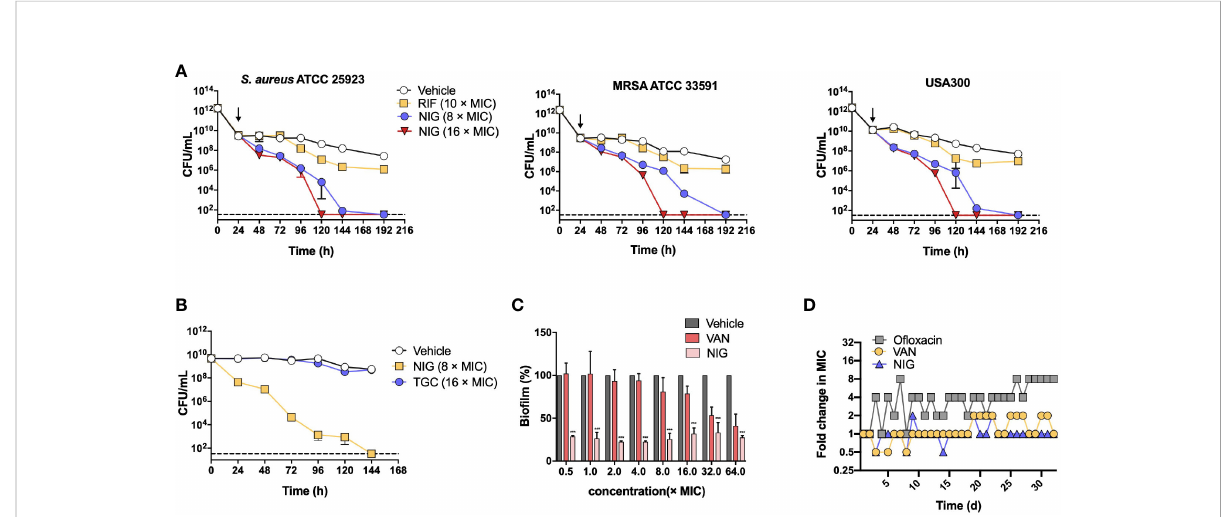
FIGURE 2 Nigericin treatment eliminates S. aureus persisters, stationary phase cells, and bio fi lms. (A) Killing of persisters. Overnight cultures of 3 S. aureus strains were treated with 100 × MIC of cipro fl oxacin for 24 h to enrich persisters. Cipro fl oxacin was removed and the indicated concentrations of nigericin (NIG) or rifampicin (RIF) were added (downward arrow) to kill the enriched persister subpopulations for the indicated times. Viable count was recorded and plotted as a function of treatment time. Vehicle (0.1% EtOH) indicating solvent for the drug was added as a control. Dash line indicates detection limit. Data are average of 3 biological replicates; error bars indicate SD. (B) Comparison of nigericin and tigecycline for killing of persisters. Persisters of S. aureus ATCC 25923 were generated from an overnight culture for 20 h to achieve stationary phase, and were then treated with nigericin (NIG, 8 × MIC), tigecycline (TGC, 16 × MIC) or Vehicle (0.1% EtOH) for the indicated times. Data were then processed as in panel (A) . (C) Killing of bio fi lms. S. aureus ATCC 25923 bio fi lms were treated for 24 h with the indicted concentrations of nigericin (NIG), vancomycin (VAN), or Vehicle (0.1% EtOH). After treatment, bio fi lms were washed and then dispersed by PBS. Samples were then serially diluted and plated on agar for viable count determination. Percent survival was calculated, using vehicle as a control, and plotted as a function of drug concentration. Data are average of 3 biological replicates; error bars indicate SD. *** p<0.001. (D) Emergence of drug resistance. S. aureus RN450 cultures were treated with 0.25, 0.5, 1, 2, 4 × MIC nigericin (NIG), vancomycin (VAN), or o fl oxacin (OFL) with daily serial passaging. At each passage samples were taken for MIC determination and the MIC values determined were ploted as a function of passage numbers (treatment times). Similar results were obtained from 3 replicate